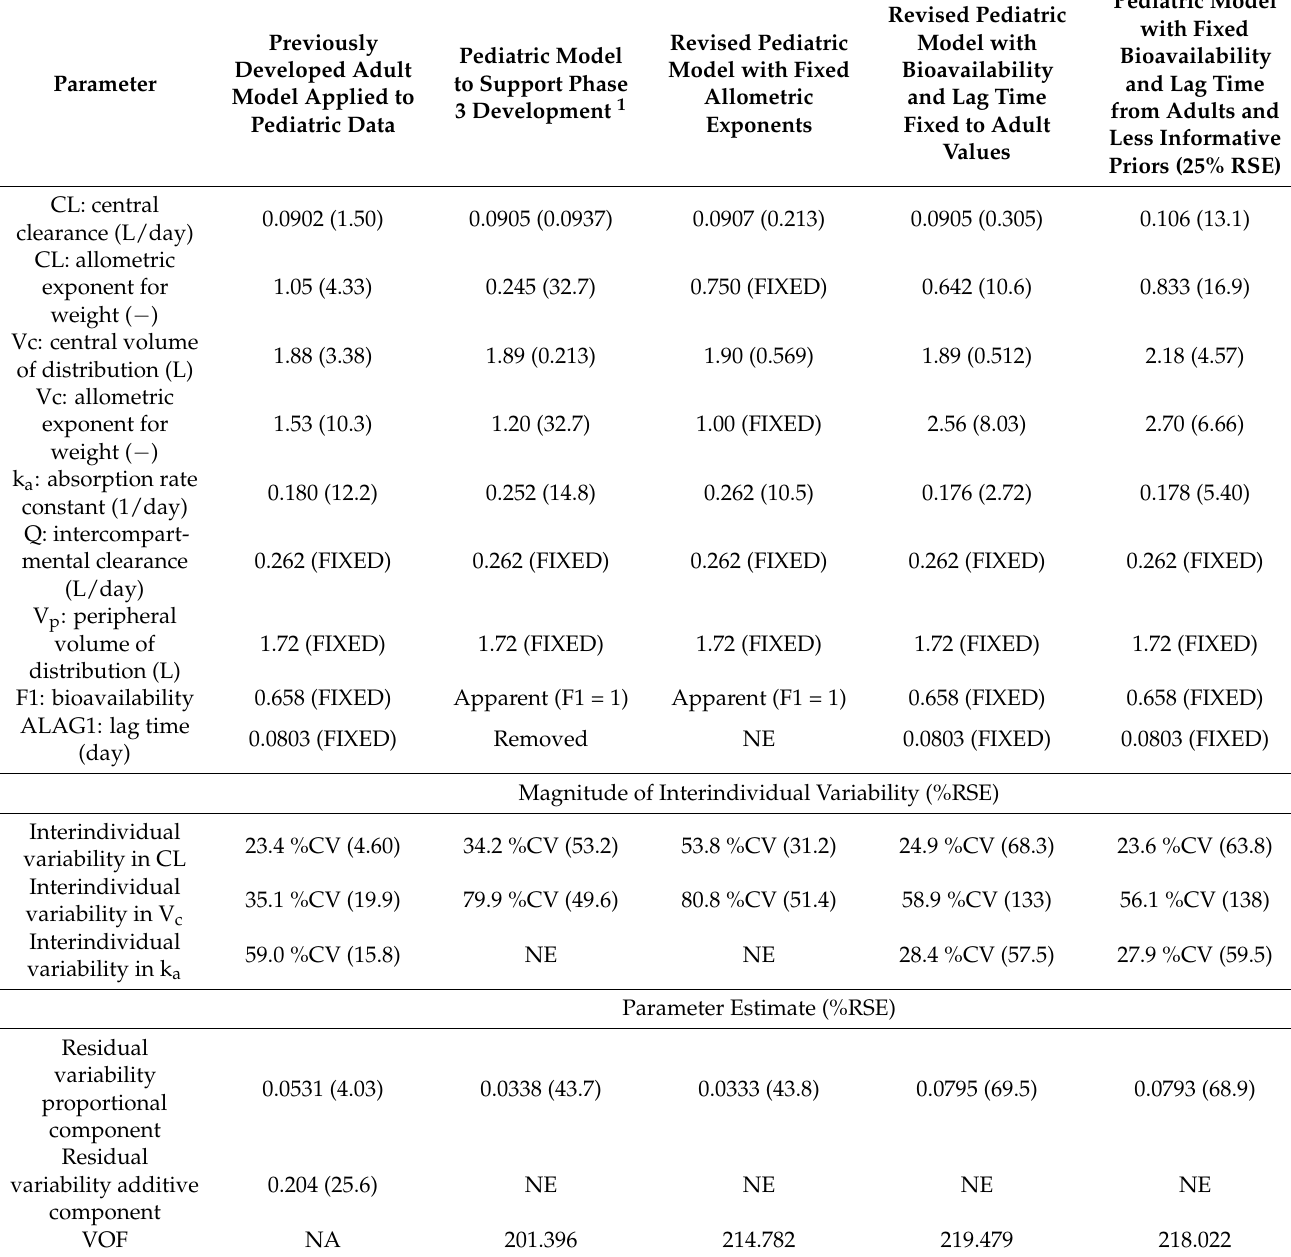
Table 1. Overall comparison of parameter estimates and standard errors for fremanezumab comparing the previously developed adult population pharmacokinetic model with the various approaches for the pediatric population pharmacoki- netic